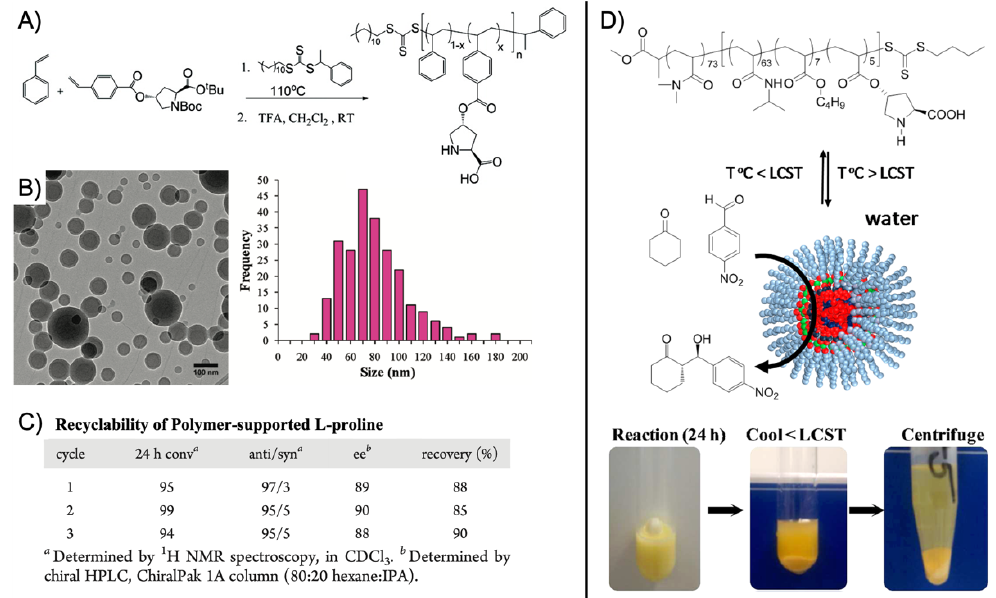
Figure 13. BCP micelles for the asymmetric aldol reaction of cyclohexanone and p -nitrobenzaldehyde in water. ( A ) RAFT polymerization of statistical P(S- co -ProlA) copolymers and assembly to large compound micelles in ( B ). ( C ) Catalysis with recycled catalyst system. ( D ) Temperature-controlled formation of micelles in water for aldol reaction of. Separation of the soluble catalytic system and insoluble aldol products in water via filtration after reaction completion. Adapted with permission of [127] and [126]. Copyright 2011 and 2013 American Chemical Society.